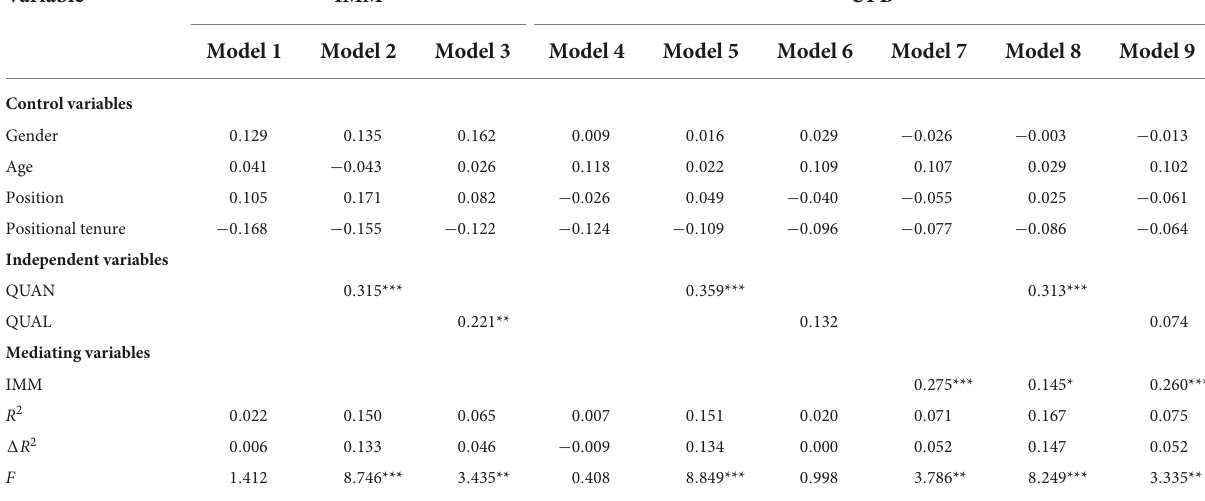
TABLE 3 Results of the multiple regression analysis of mediating effects ( N =